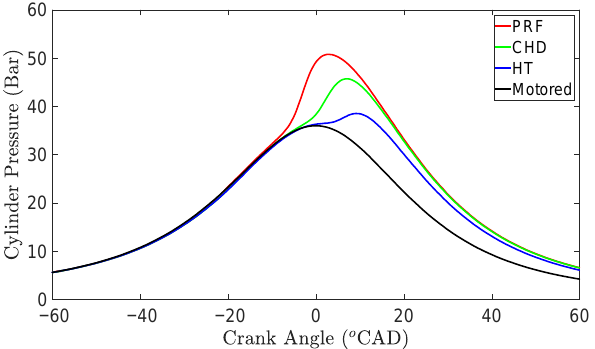
Figure 7. Combustion pressure for the three fuels and motored pressure with T inlet 90 ◦